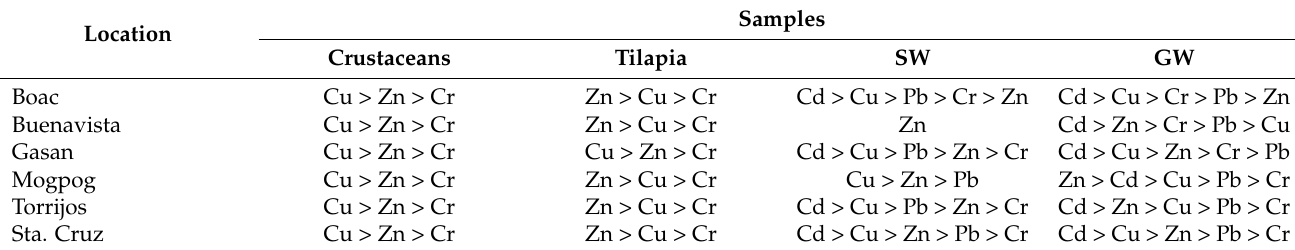
Table 9. Trend of potential ecological risk coefficient in crustaceans, tilapia, SW, and GW. Location